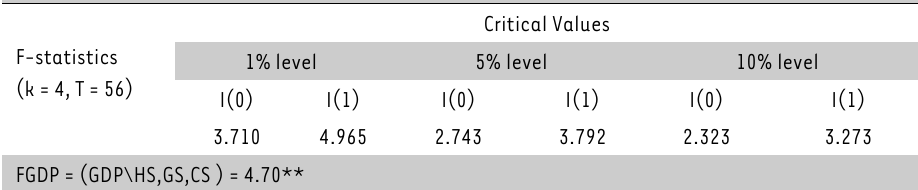
Cointegration test results